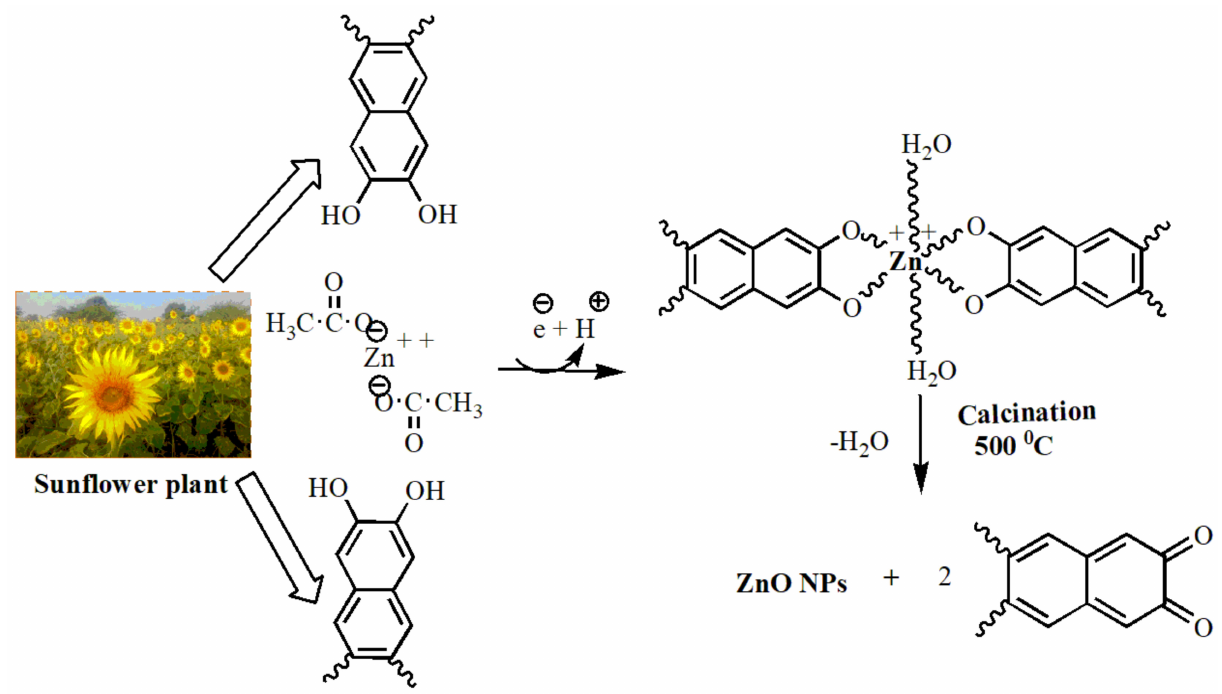
Figure 2. A possible mechanism for the synthesis of ZnO NPs using sunflower-leaf aqueous